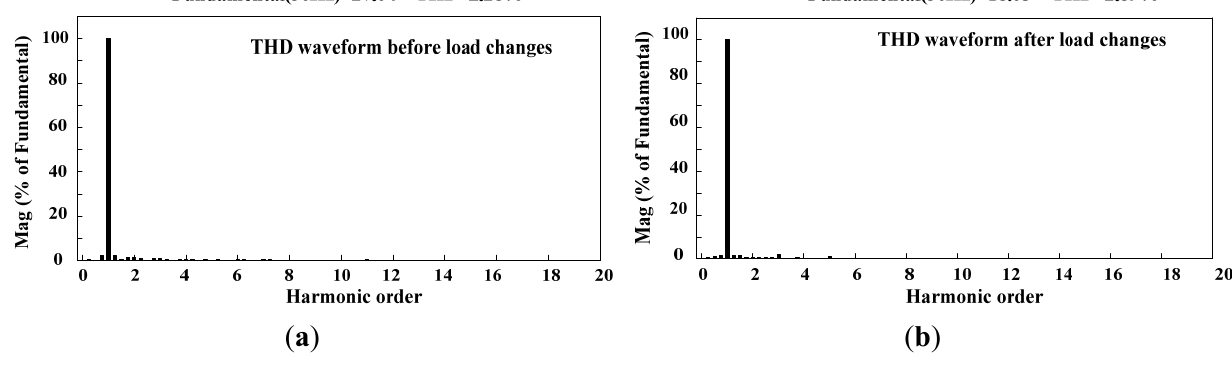
Figure 10. Control frame of system grid side converter. ( a ) Before load changes; ( b ) After load changes.